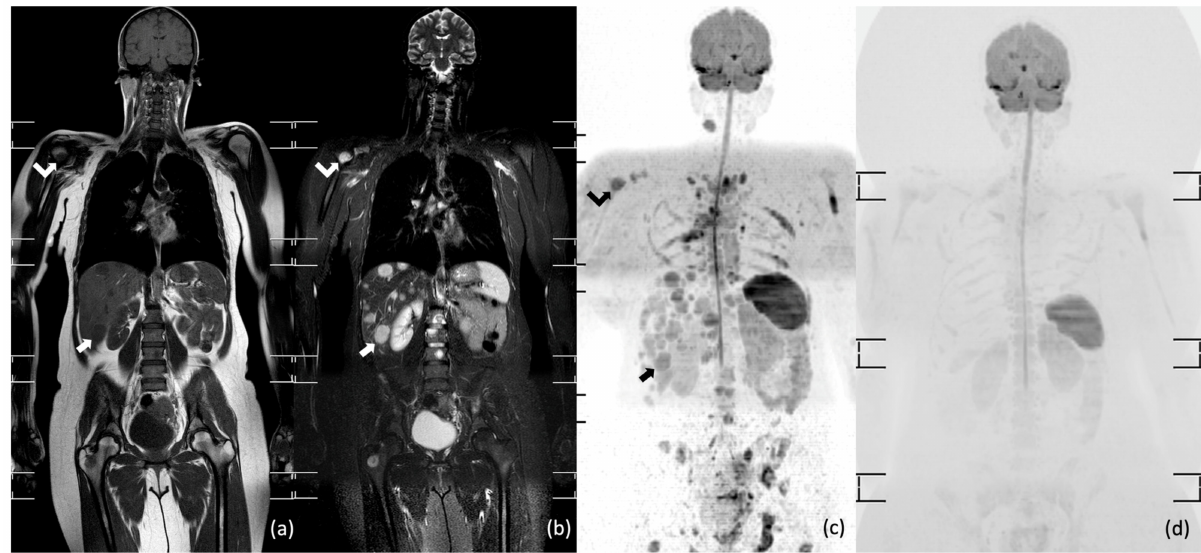
Figure 5. Whole-body MRI of a 36-year-old woman with non-Hodgkin diffuse B-cell lymphoma, treated with six courses of DA-REPOCH. Pre-treatment coronal T1-weighted ( a ); pre-treatment coronal short tau inversion recovery (STIR) ( b ); pre-treatment maximum intensity projection (MIP) b 800 grey-scale inverted DWI ( c ); post-treatment maximum intensity projection (MIP) b 800 grey-scale inverted DWI ( d ). Pre-treatment images show multiple hepatic (white arrow in ( a , b ) and black arrow in ( c ) and bone (white curved arrow in ( a , b ), black curved arrow in c ) locations of disease with complete response after treatment ( d